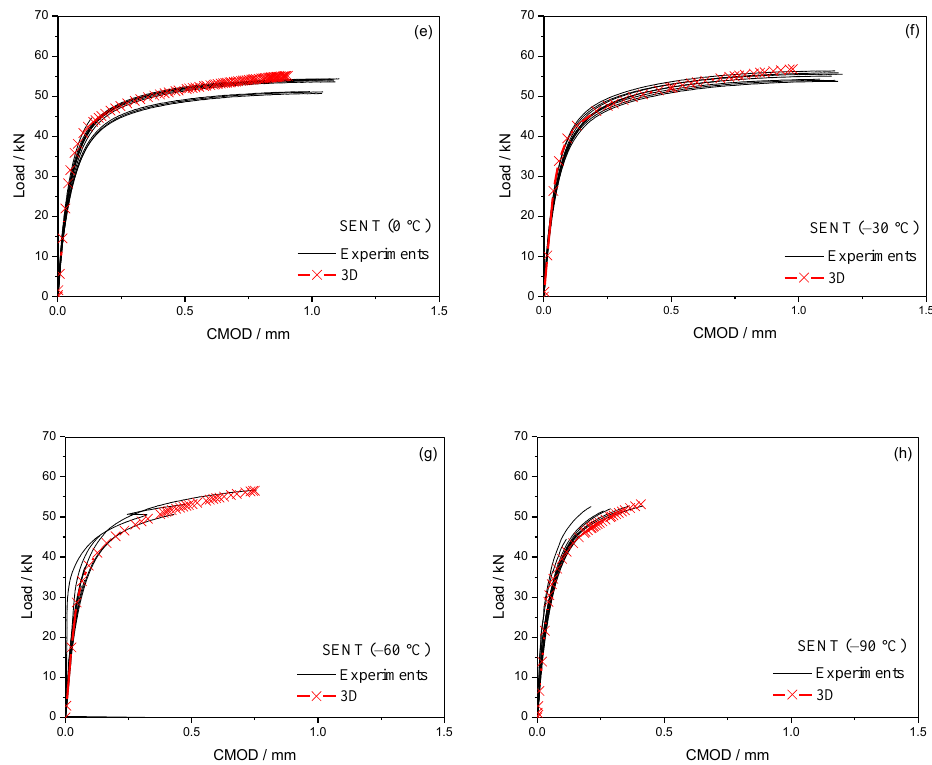
Figure 6. Comparisons of measured and calculated load-CMOD curves for SENB [25] and SENT specimens at various temperatures. ( a ) 0 °C for SENB specimens, ( b ) −30 °C for SENB specimens, ( c ) −60 °C for SENB specimens, and ( d ) −90 °C for SENB specimens, ( e ) 0 °C for SENT specimens, ( f ) −30 °C for SENT specimens, ( g ) −60 °C for SENT specimens, and ( h ) −90 °C for SENT specimens.